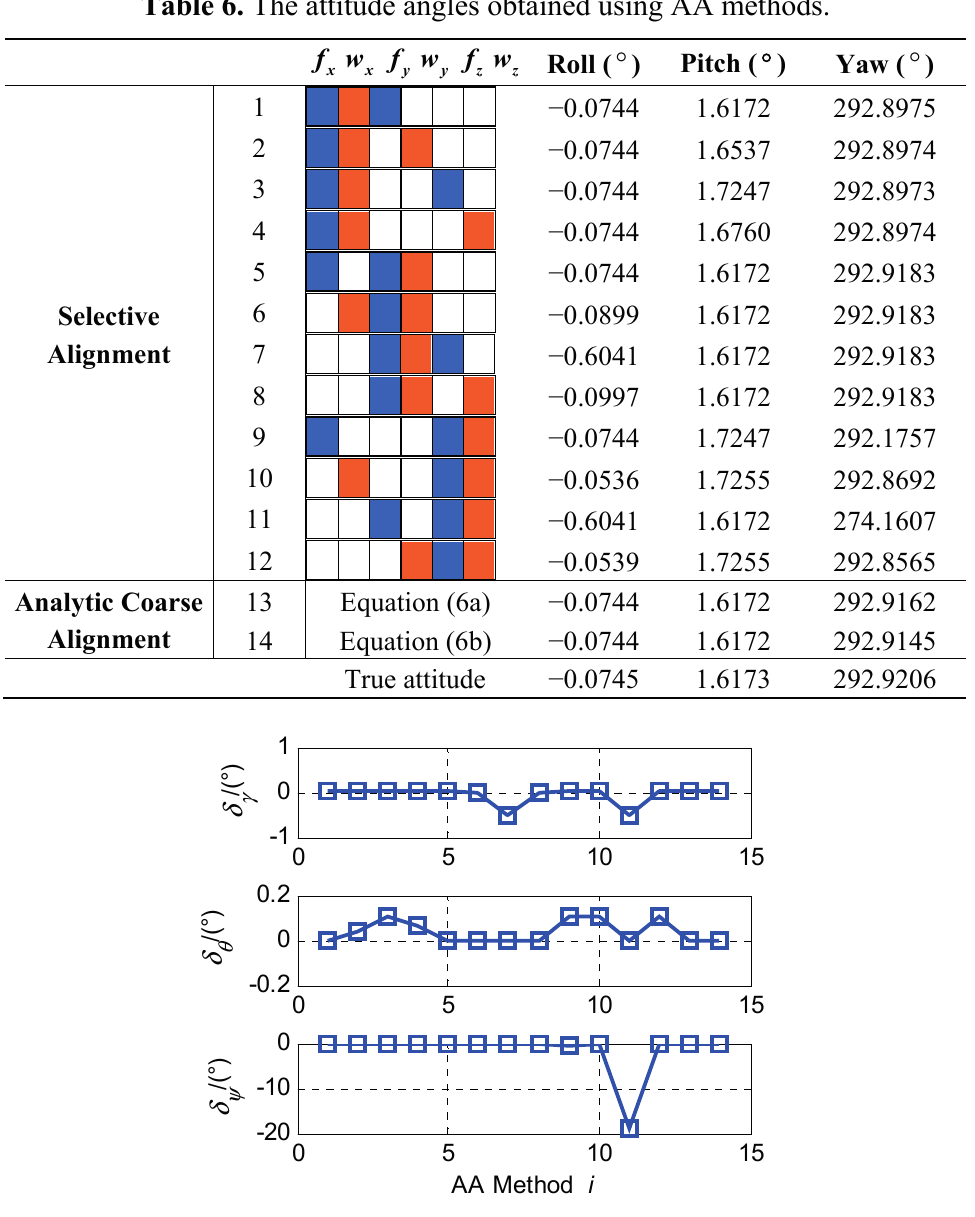
Figure 10. The errors of the attitude obtained using AA